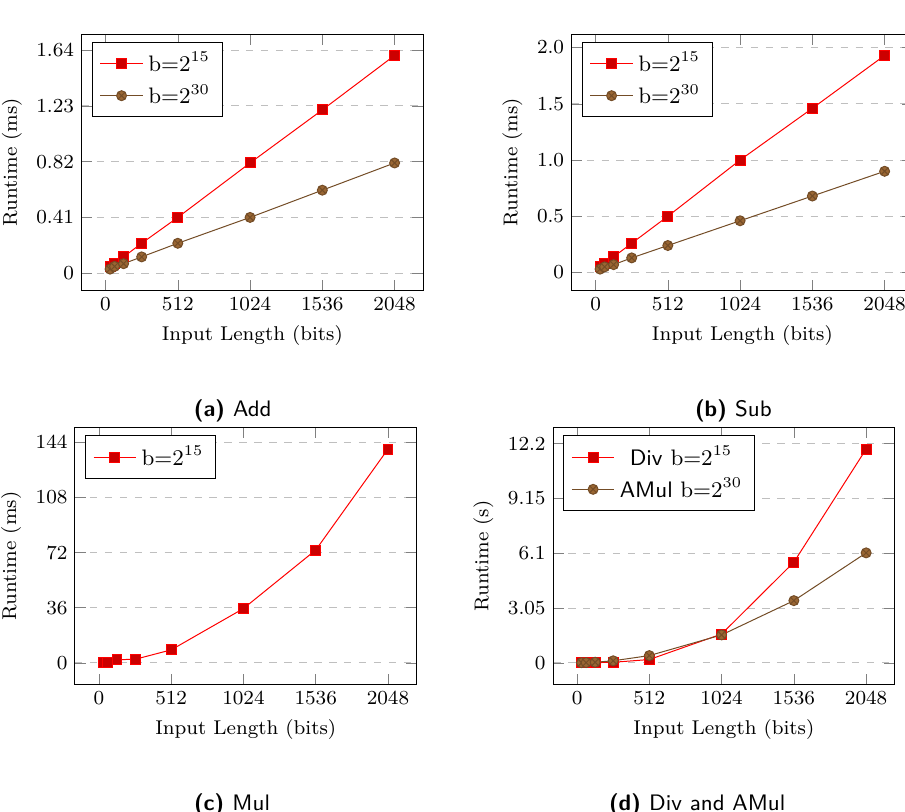
Figure 9: Runtimes of Big-integer